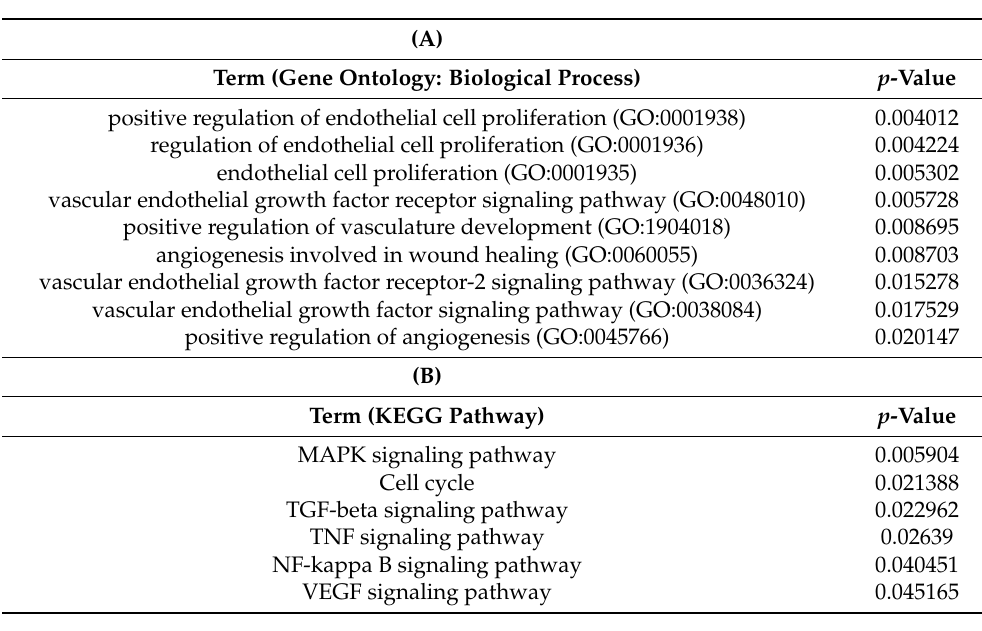
Figure 2. Transcriptomic analysis of HLMVECs under baseline conditions without LPS challenge. Heatmap represents transcriptomic analysis of differentially expressed genes between the DPP4 siRNA (NC)—and negative control siRNA (NC)—treated HLMVECs. Table 2. Enrichment analysis of transcriptomic data ( DPP4 siRNA/PBS vs. negative control/PBS). (A) Gene ontology (biological process): DPP4 siRNA/PBS vs. negative control/PBS. (B) KEGG pathway: DPP4 siRNA/PBS vs. negative